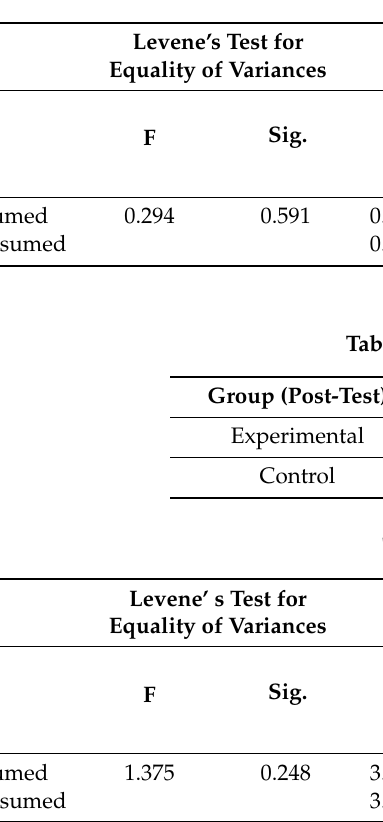
Table 3. Independent samples test (pre-test).